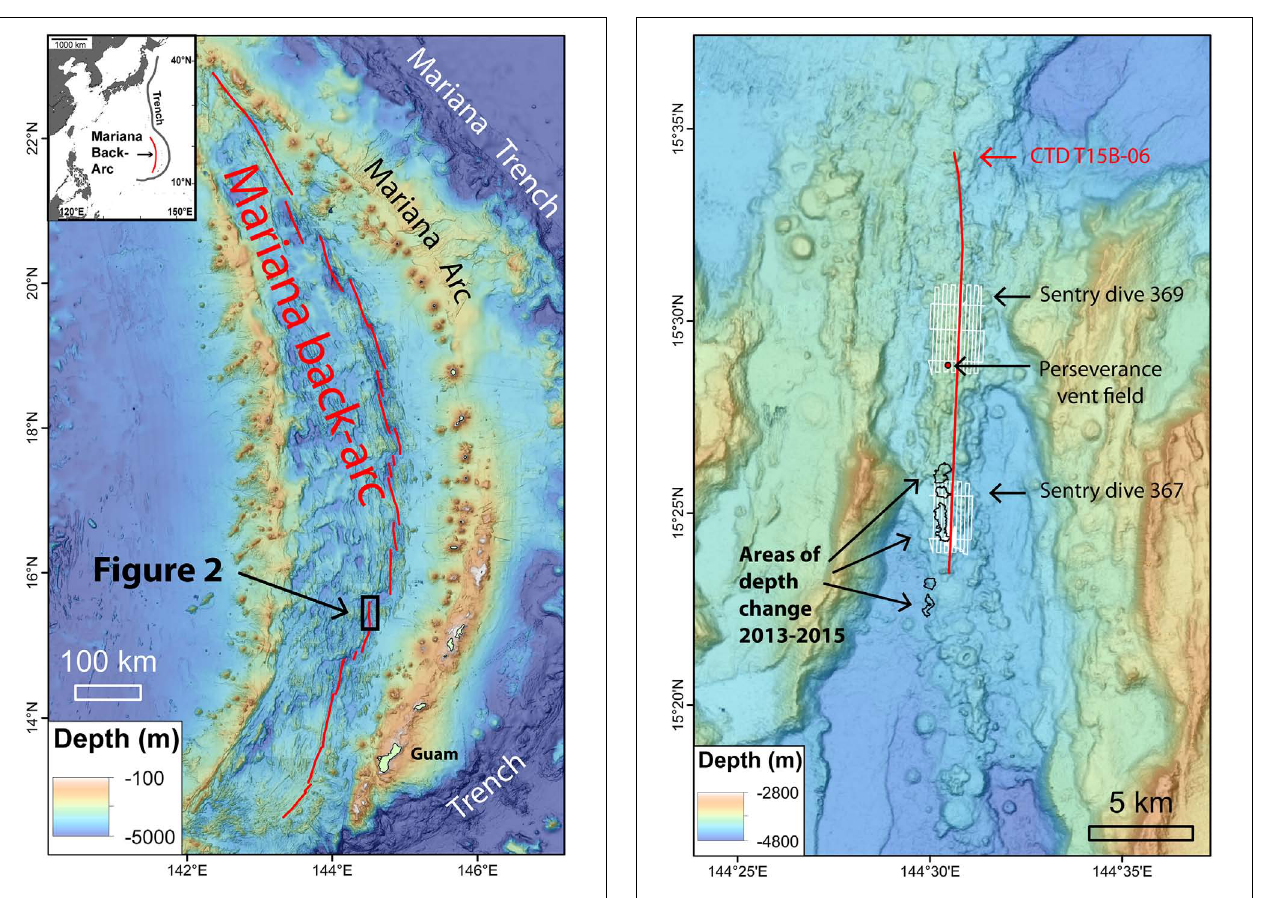
FIGURE 2 | Bathymetric map of the 15.5 ◦ N segment of the Mariana back-arc showing the location of CTD tow T15B-06 (red line; data shown in Figure 3 ), AUV Sentry dives 369 and 367 (white lines; the latter shown in Figure 4 ), and areas of depth change between bathymetric surveys in 2013 and 2015 (black outlines; data shown in Figure 6 ). Red dot shows location of Perseverance vent